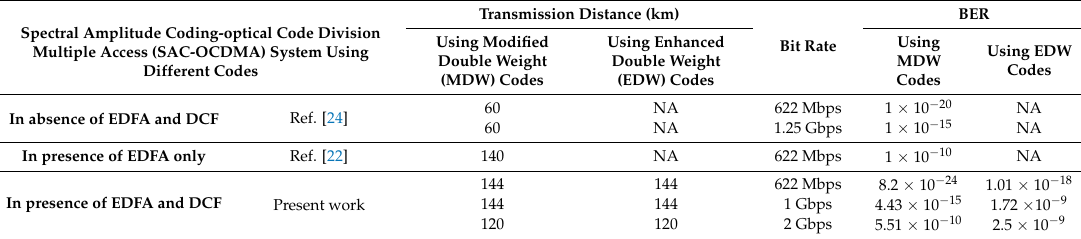
Table 4. Bit error rate (BER) summary and comparison.